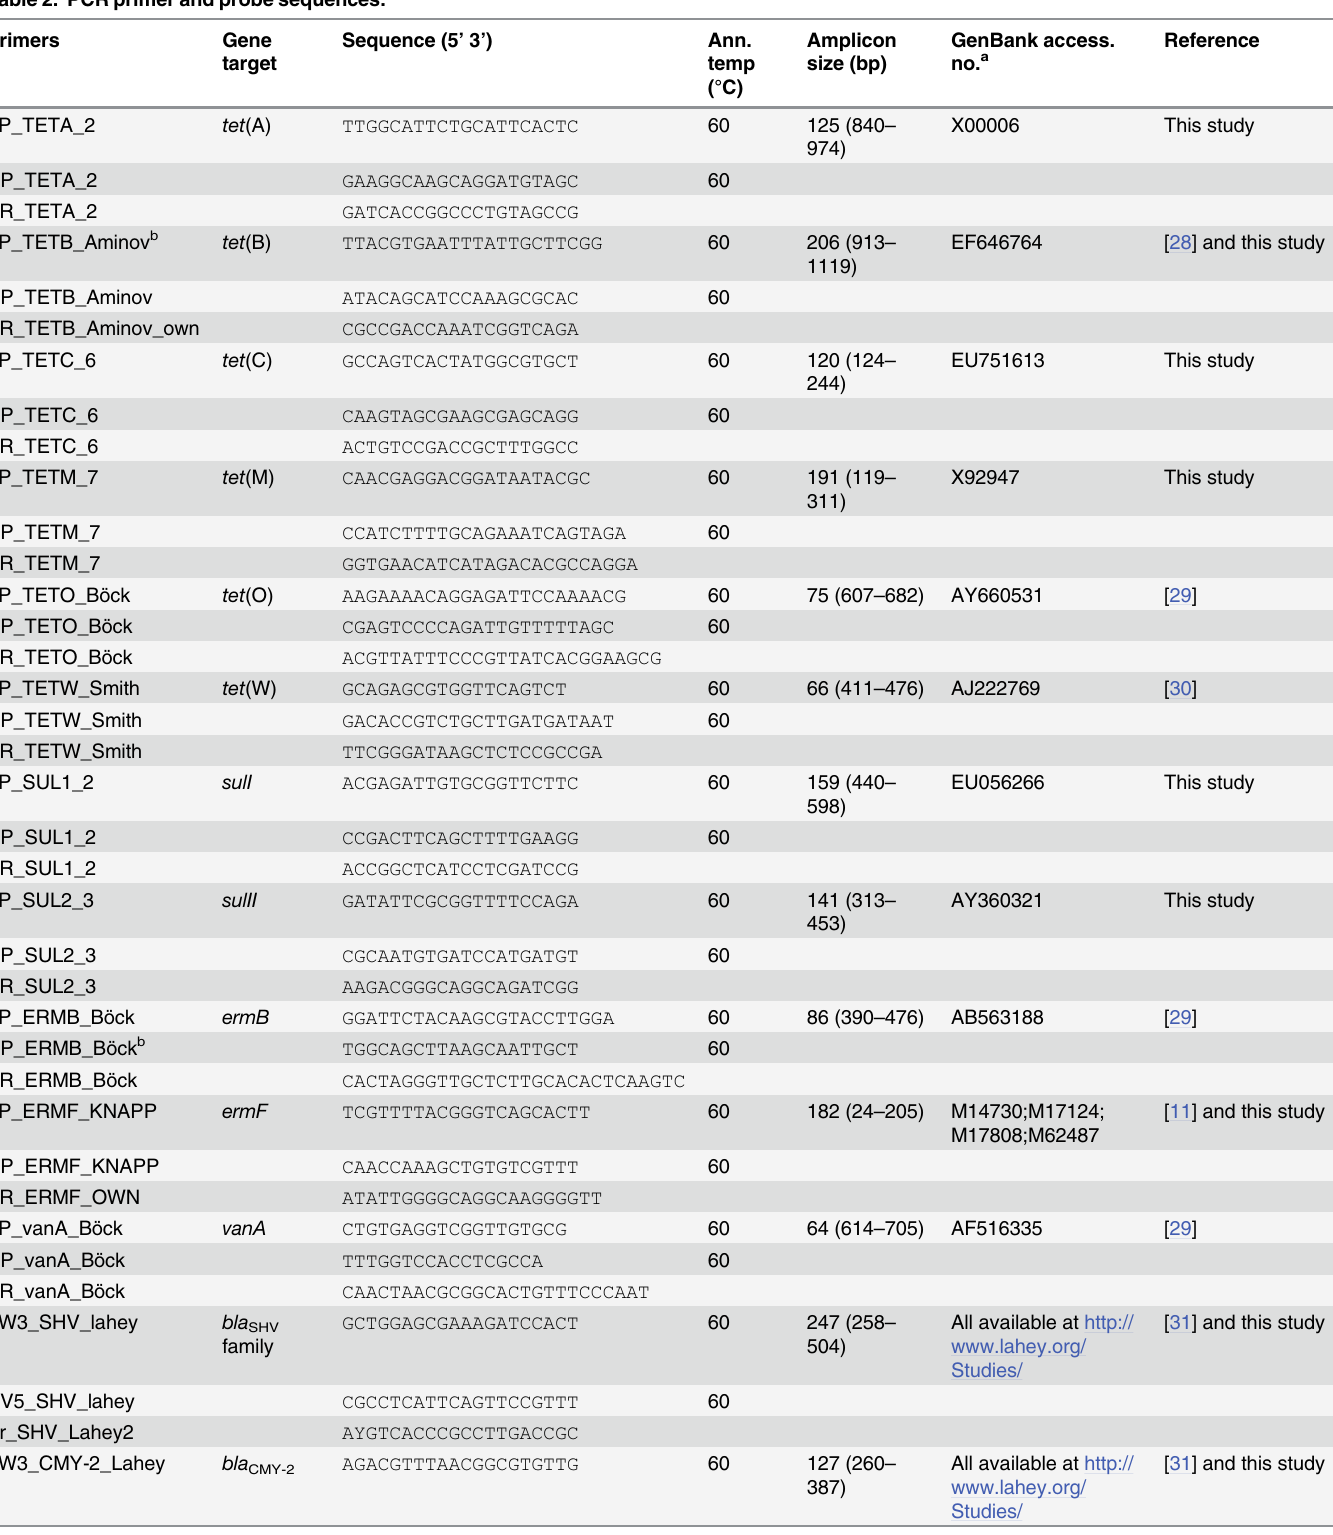
Table 2. PCR primer and probe